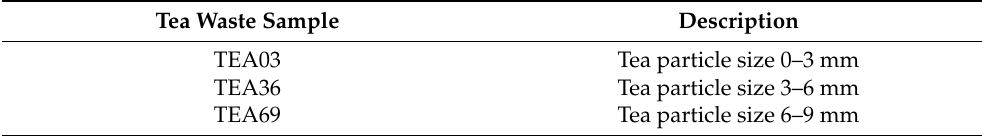
Table 1. List of samples by particle size.